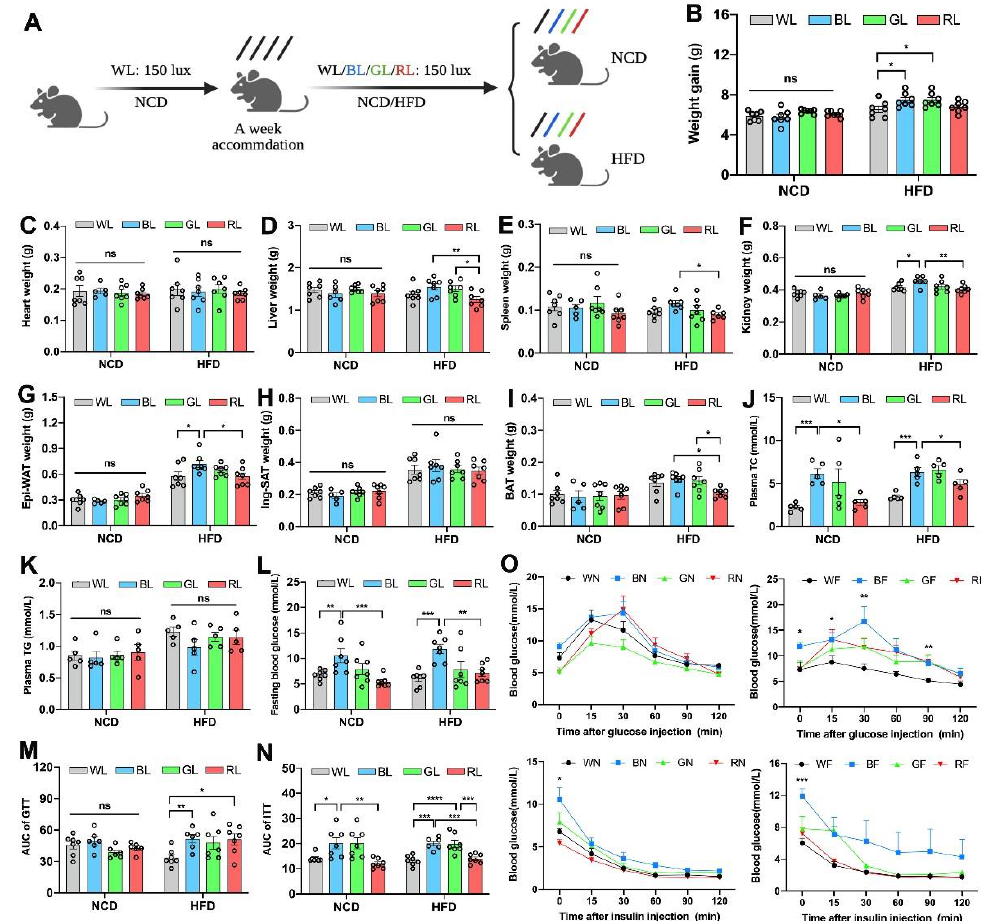
Figure 1. Influences of monochromatic light exposure on metabolic disorders in mice. ( A ) Schematic diagram of animal experiments. ( B ) Body weight gain ( n = 7). ( C – I ) Weights of the heart, liver, spleen, kidney, Epi-WAT, Ing-WAT, and BAT ( n = 7). ( J , K ) Plasma TC and TG concentrations ( n = 5). ( L ) Fasting blood glucose level ( n = 7). ( M – O ) GTT and ITT curve and relevant AUC ( n = 7). The circles represent the number of samples. The results are presented as the means ± SEM. * p < 0.05, ** p < 0.01, *** p < 0.001, **** p <